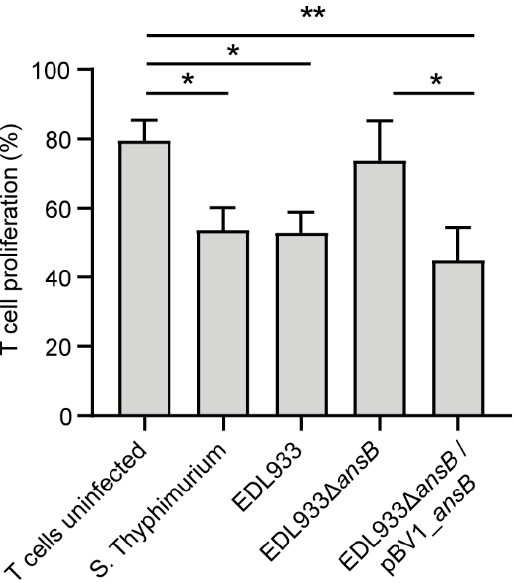
Figure 5. Proliferation of CFSE-labeled T cells. T cells were left uninfected (negative control) or cultured with the EDL933, EDL933 ∆ asnB and EDL933 ∆ asnB / pVB1_ ansB strains. As a positive control, T cells were cultured with S. Typhimurium. Error bars show standard deviation (SD). Data were analyzed by one-way ANOVA. * p < 0.05, ** p < 0.005.